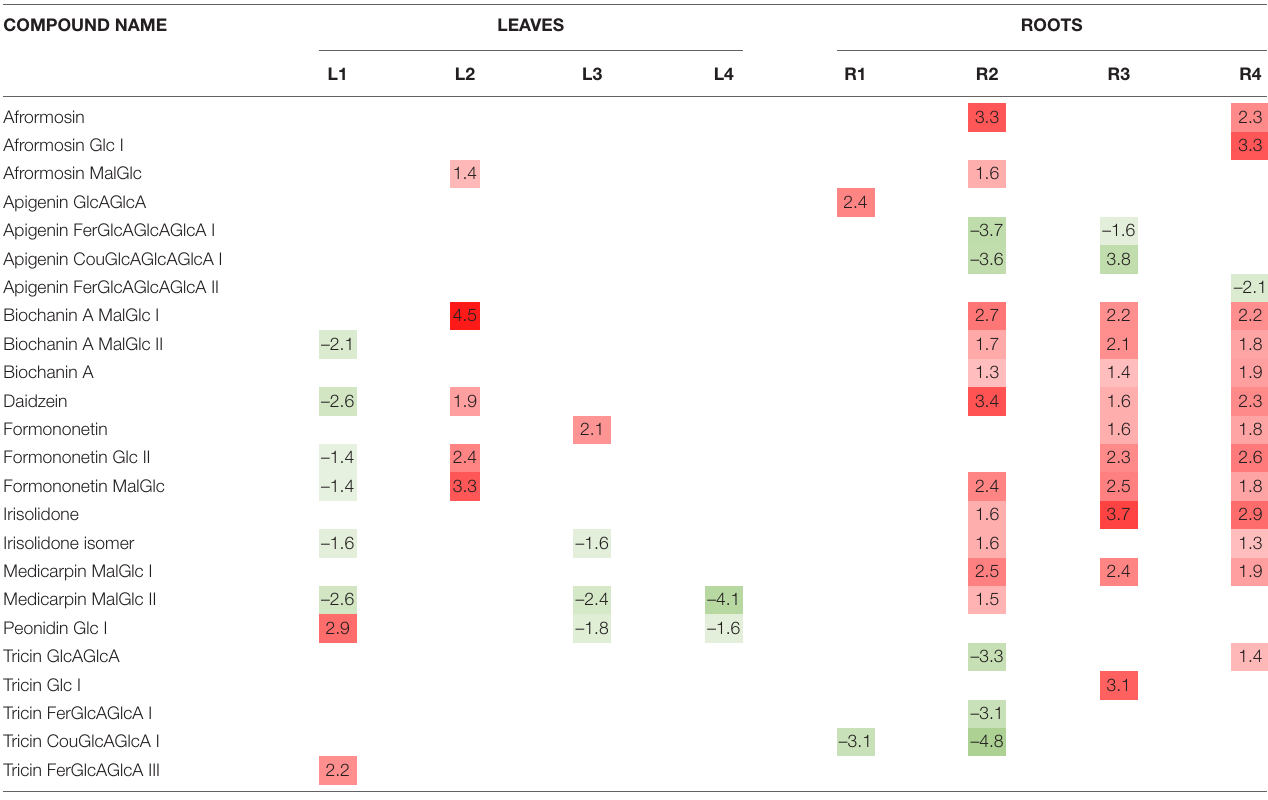
TABLE 2 | Differentially accumulated flavonoids (Log 2 FC) in Medicago truncatula varieties after